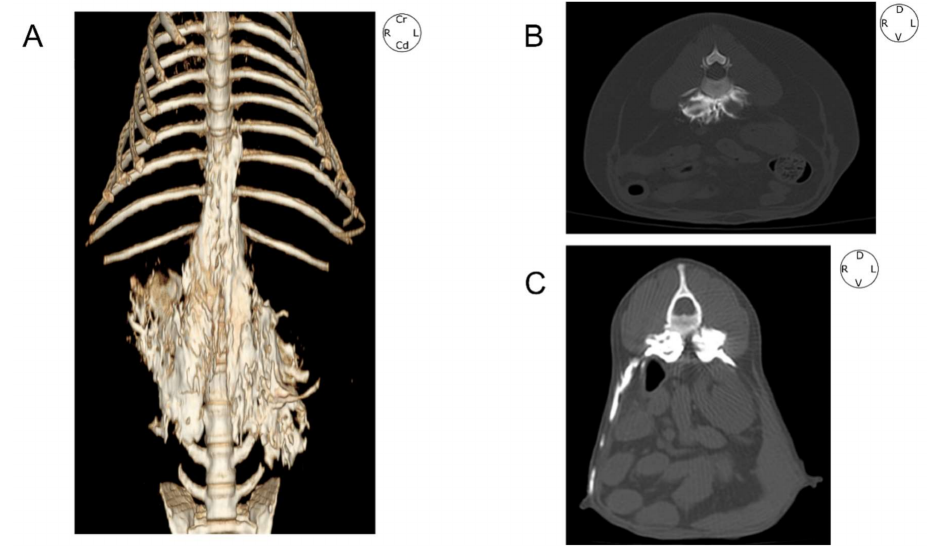
Figure 5. Computed tomographic images of the contrast spread after the administration of 0.6 mL kg − 1 of a mixture of methylene blue and iopromide by a modified QL approach. ( A ) Volume- rendered three-dimensional projection image viewed from a ventral perspective of the thoracolumbar region. ( B ) Transverse image at L2 level with bone window setting. ( C ) Transverse image at L3 level showing contrasts presence in the left transverse abdominal plane. QL, quadratus lumborum block; L2; second lumbar vertebra; L3, third lumbar vertebra; Cr, cranial; Cd, caudal; L, left; R, right; D, dorsal; V,